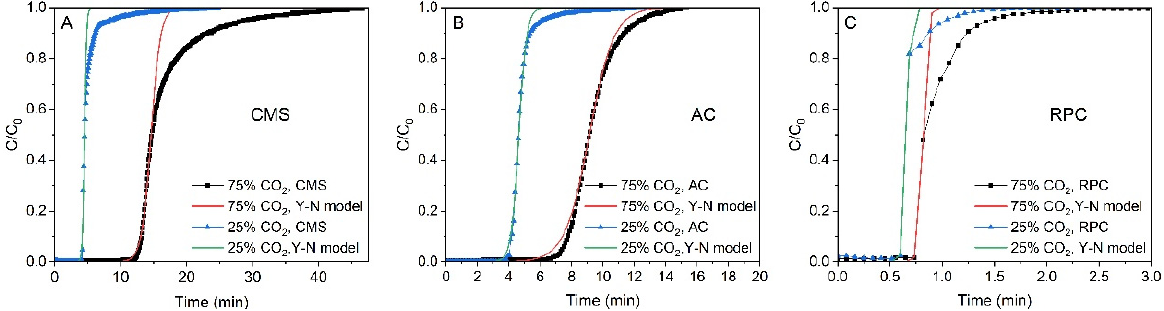
Figure 4. The experimental and predicted breakthrough curves of CO 2 for CMS ( A ), AC ( B ), and RPC ( C ) samples at 1 bar and 293 K.